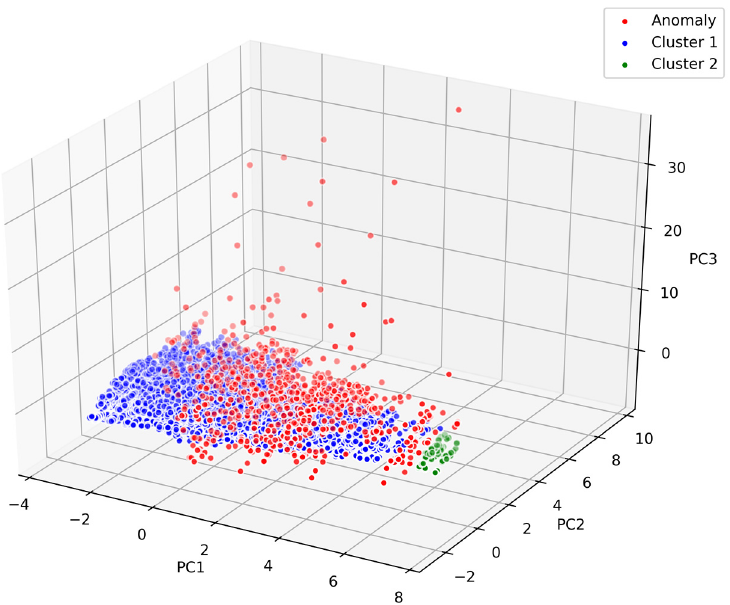
Figure 6. Preliminary clustering results of the dataset D1a using hierarchical density-based spatial clustering of applications with noise (HDBSCAN).